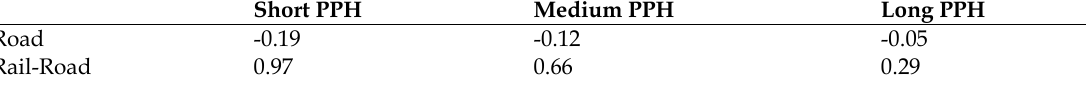
Table 4. Elasticity per Pre- Post-Haulage (PPH) distance, rail cost -5% Short PPH Medium PPH Long PPH Road 0.11 0.14 0.13 Rail-Road -0.54 -0.70